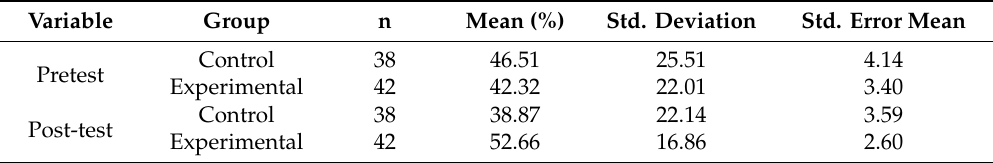
Table 4. Means, standard deviations, and standard error mean of the experimental and control groups for the pretest and post-test scores, graded according to a 0–100